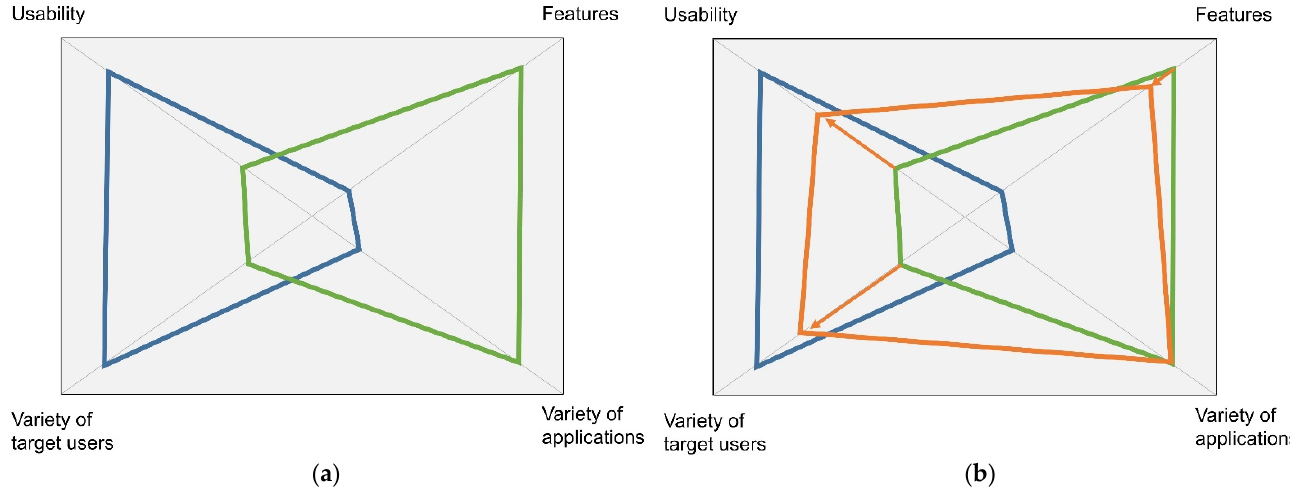
Figure 1. Simplified spider diagrams compare different approaches for web-based EO data analyses ( a ): systems and interfaces that are easy to use and target various users are less transferable to general applications and provide fewer features (blue polygon), e.g., map viewers. Systems and interfaces with high applicability and many features are more difficult to use and require programming skills, limiting the target users (green polygon), e.g., web-based code editors. ( b ) It is an ongoing research gap to provide better usability for a larger target group while sacrificing as few features as possible and being generally applicable to various application domains (orange polygon). Specialized cloud services, such as the Copernicus Data and Information Access Services (DIAS), which provide virtual machines (VM) that need to be managed by users themselves, are considered here as a different layer in the technology stack.